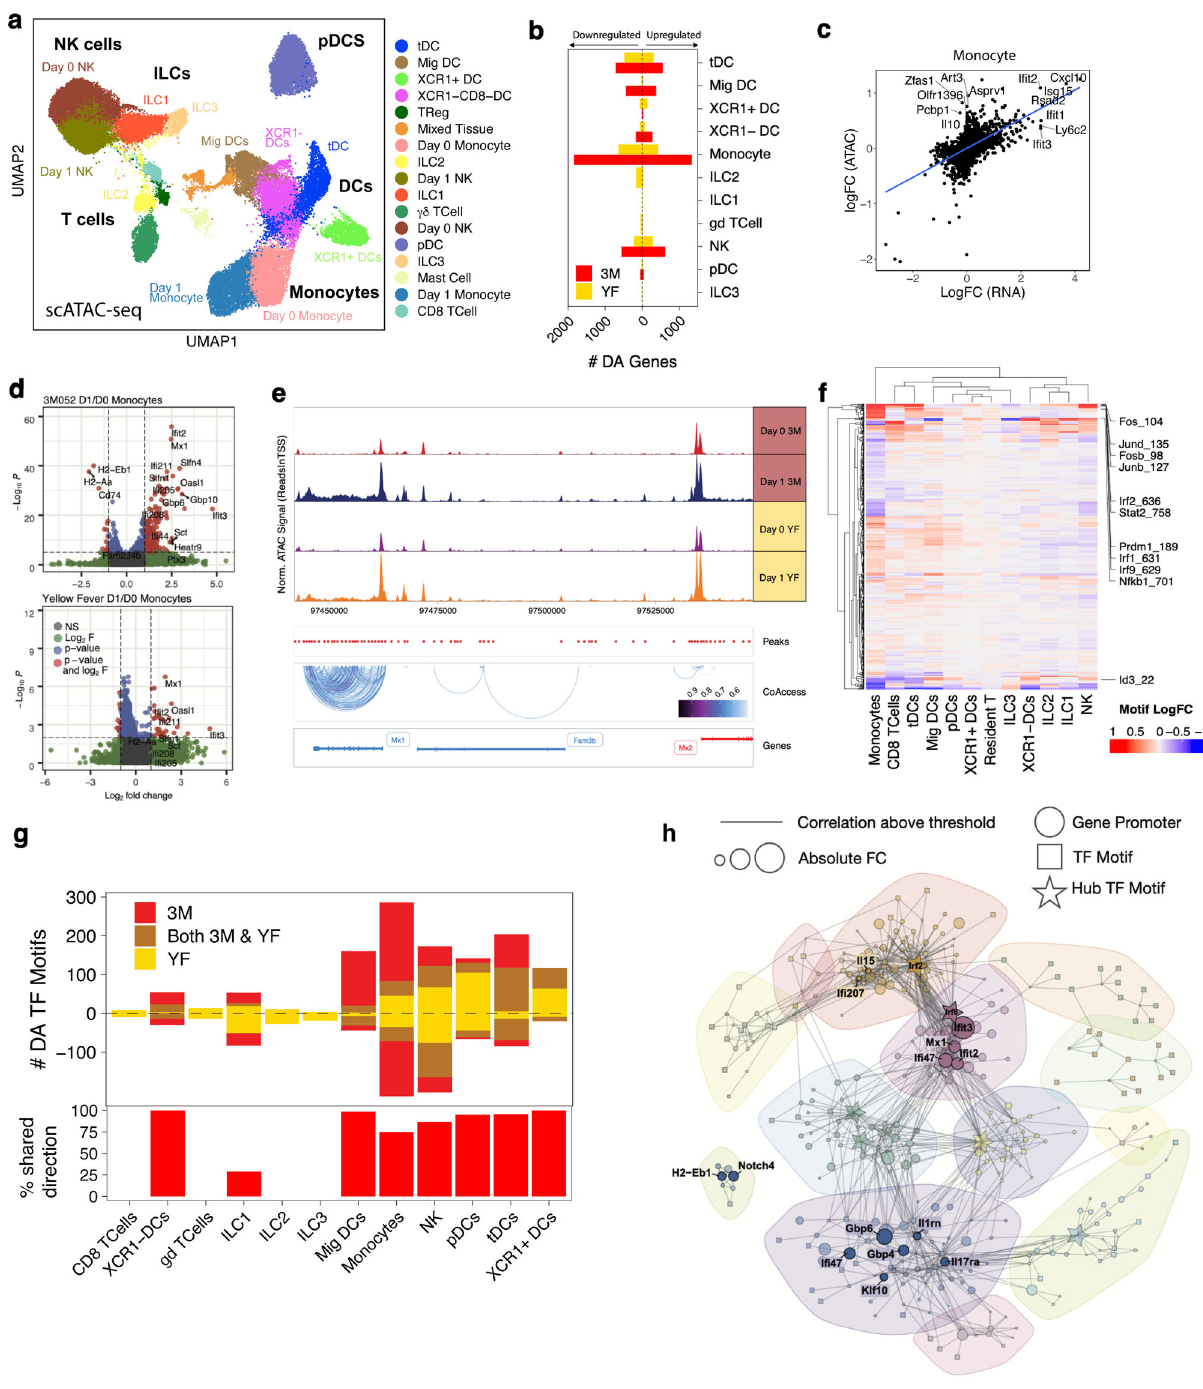
Fig. 4 scATAC-seq reveals differential TF motif accessibility between 3M-052-Alum/OVA and YF-17D. a UMAP embedding of 44327 cells from innate immune cells immunized with 3M-052-Alum/ OVA or YF-17D. b Differentially accessible genes, FDR<0.05 and absolute logFC > 0.1. c Correlation between logFC in monocytes in scATAC and scRNA-seq. R is Pearson ’ s correlation. d Volcano plots of gene accessibility logFC in monocytes in 3M-052-Alum/OVA and YF-17D. e Representative tracks of an Irf inducible site on Chromosome 16, spanning genes Mx1 and Mx2. Peaks are shown in red below the track. f TF logFC 1 day after 3M-052-Alum/OVA immunization. g Top, differentially accessible TF motifs (FDR< 0.05) 1 day after immunization. Bottom, the percentage of 3M-052-Alum/OVA DA TF motifs that change in the same direction after YF-17D immunization. h The accessibility correlation network of genes and transcription factors in day 1 monocytes. Each node is a differentially accessible gene or TF; edges represent the correlation between sampling of expression at varying timepoints could elucidate genes demonstrating different “ waves ” of activation.